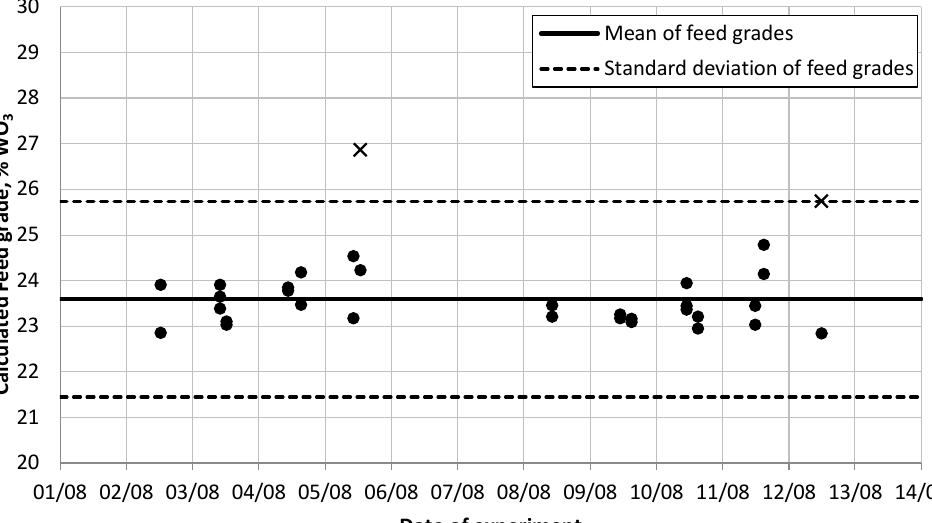
Figure 16. Variation in WO 3 feed grade over all experimental runs. X denotes outliers removed from the dataset. Table 5. Adjusted R2 values for fitted models of grade and recovery.